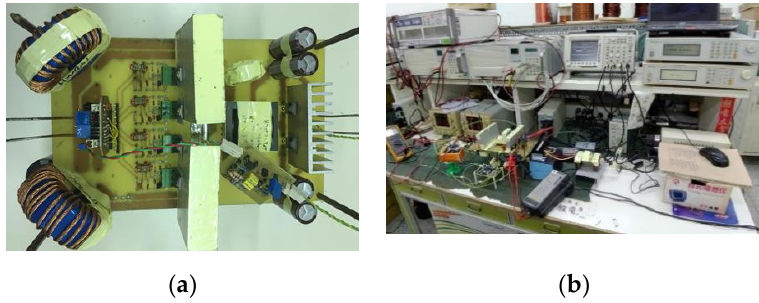
Figure 5. Pictures of the proposed converter, ( a ) prototype circuit, ( b ) experimental setup.